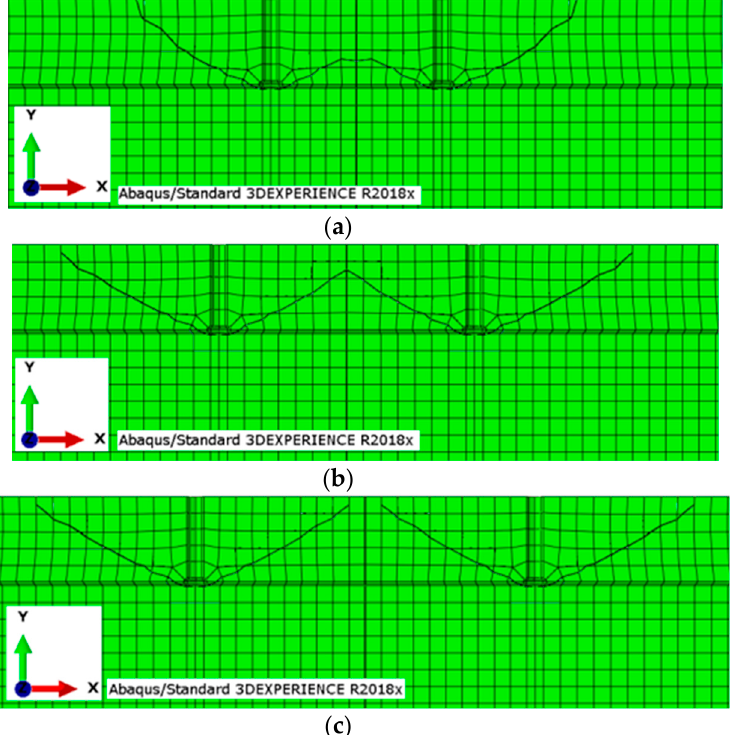
Figure 6. The anchor group effect in cone failure for a group of 2 anchors relative to anchor spacing: ( a – d ) h ef = 100 mm and the spacing s between the holes: ( a ) 100, ( b ) 150, ( c ) 200, d ) 300 mm, ( e,f ) h ef = 50 mm and the spacing s between the holes: ( e ) 50 mm, ( f ) 100 mm.